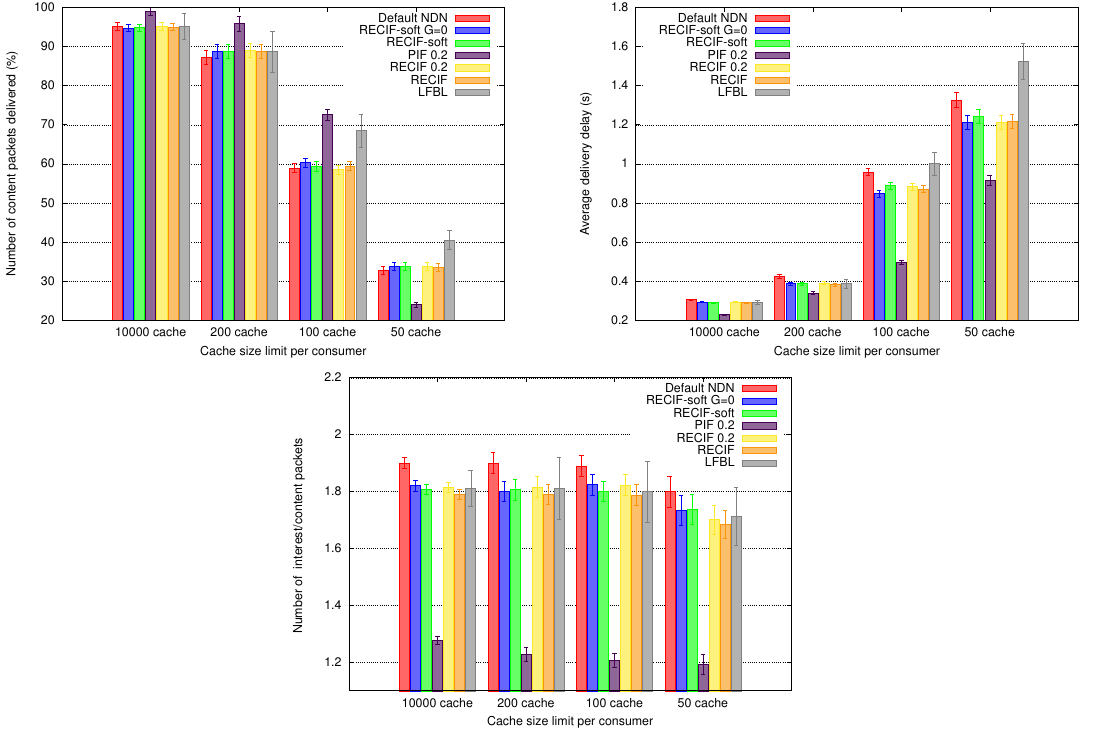
Figure 10. Content packets delivered, average delivery delay, and overhead for two consumers requesting popular content with different cache